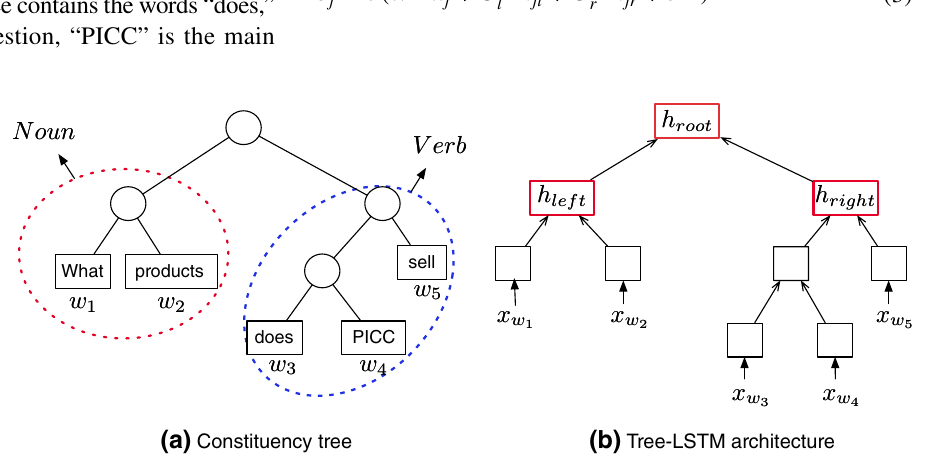
Fig. 3 Constituency tree and the corresponding tree-LSTM